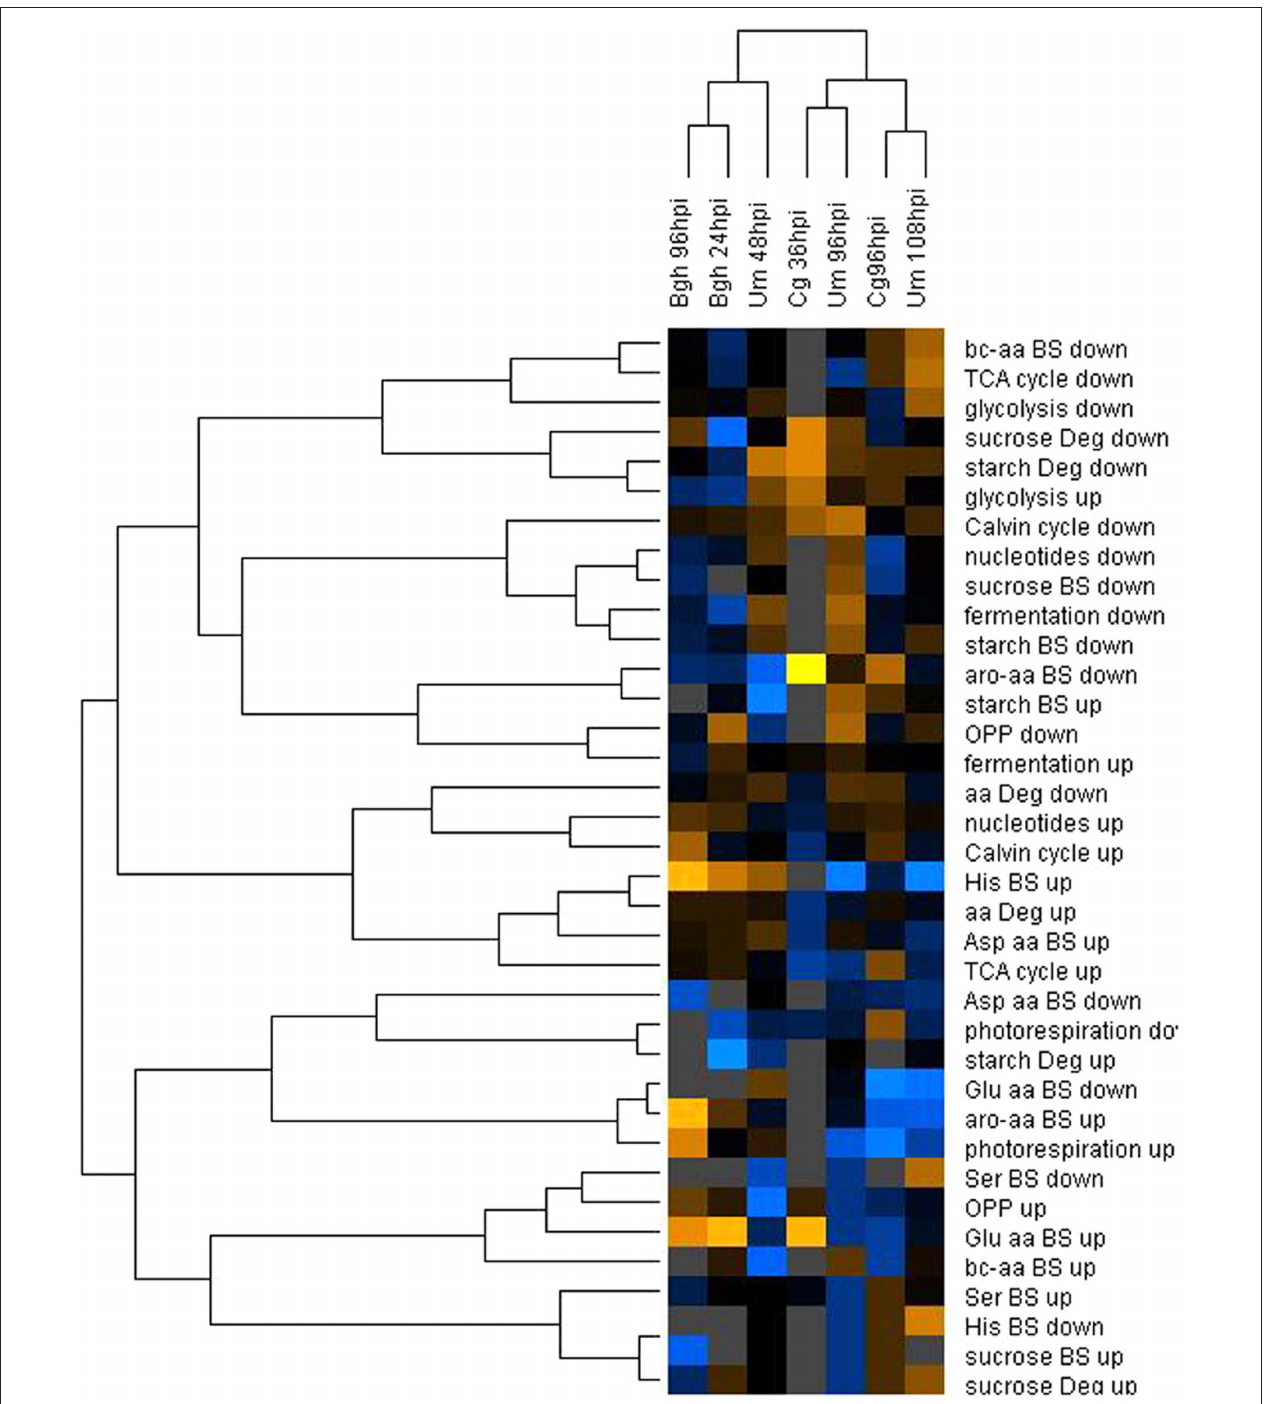
Color intensity correlates with degree of increase (yellow) and decrease (blue) relative to the BIN mean of all samples, while gray corresponds to 0% regulated genes in the MapMan BINs. Bgh, Blumeria graminis f.sp. hordei ; Cg, Colletotrichum graminicola ; Um, Ustilago maydis; hpi, hours post infection. Amino acids are abbreviated by three letter code; aro-aa, aromatic amino acids; bc-aa, branched-chain amino acids; BS, biosynthesis; Deg, degradation; OPPP, oxidative pentose